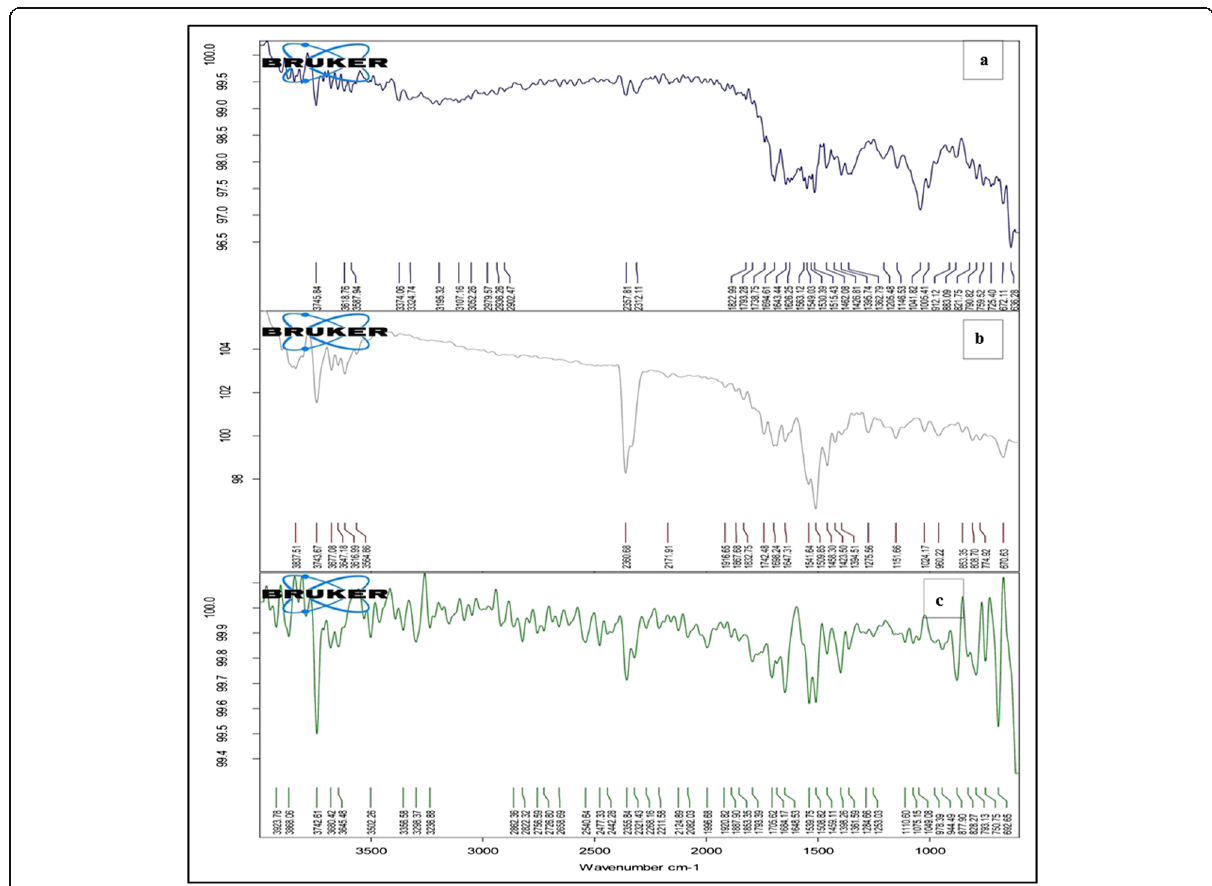
Fig. 2 Infrared spectra of a Green tea extract, b Curcumin, and c